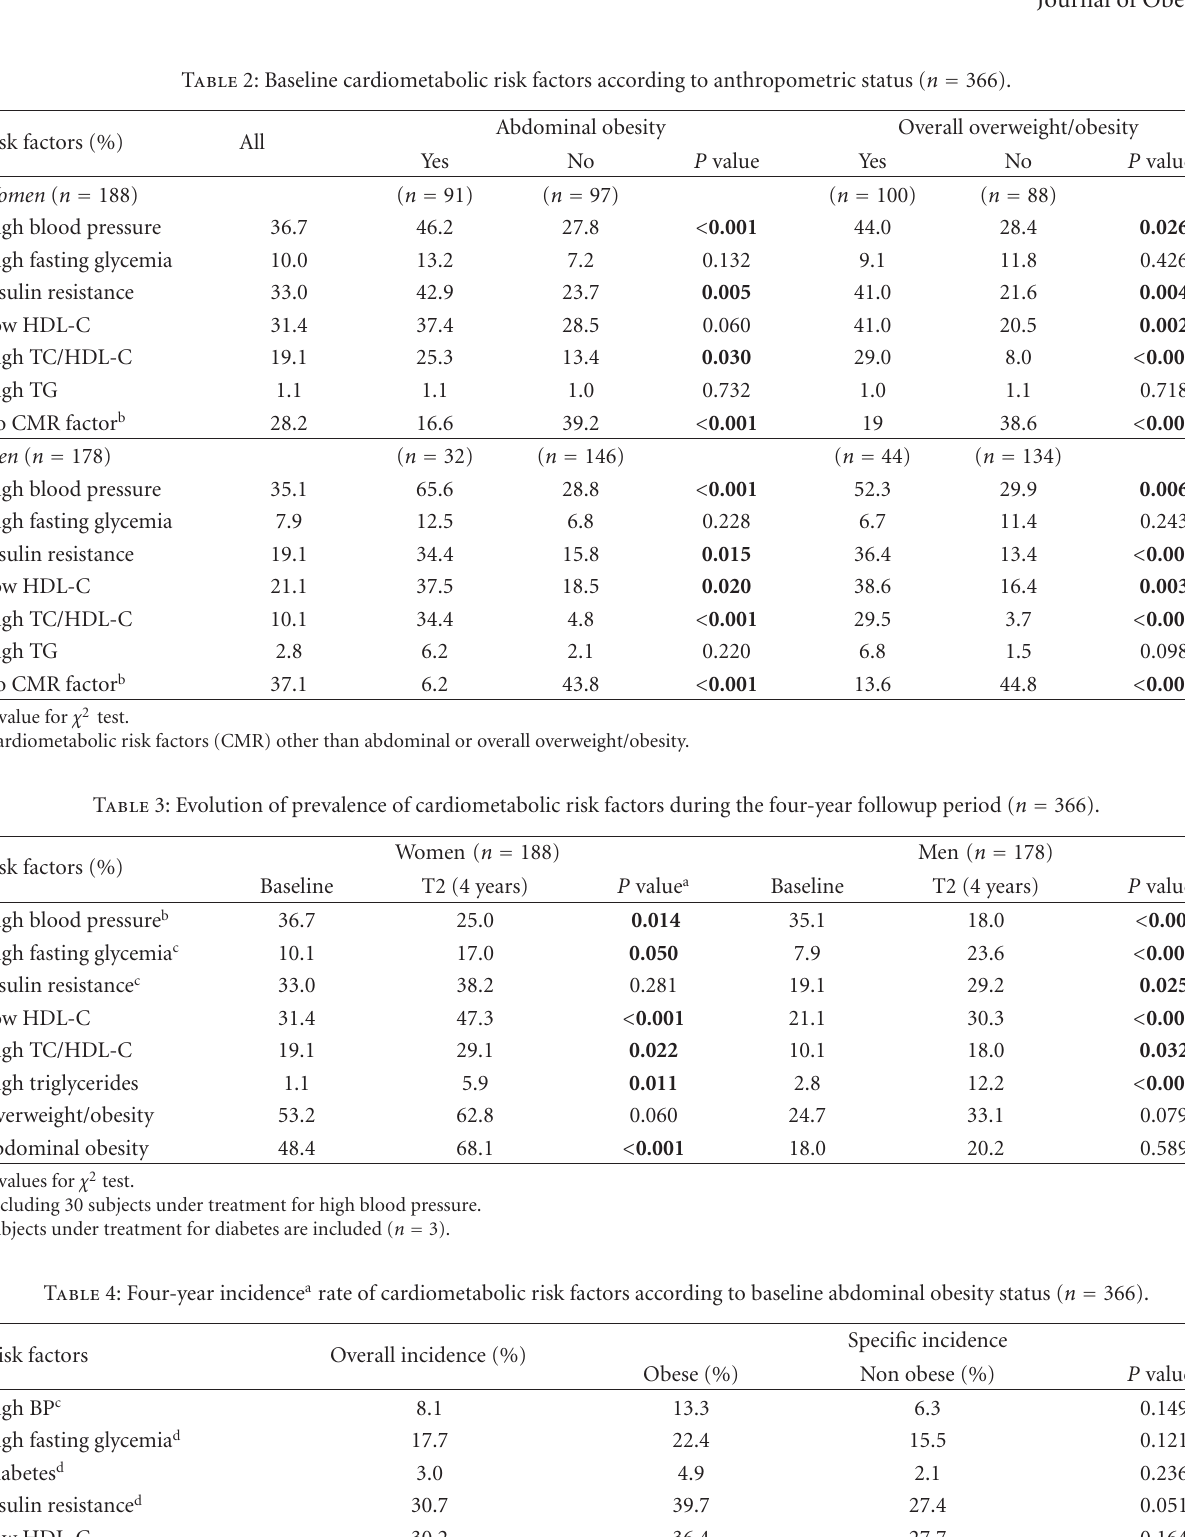
Table 2: Baseline cardiometabolic risk factors according to anthropometric status ( n = 366).